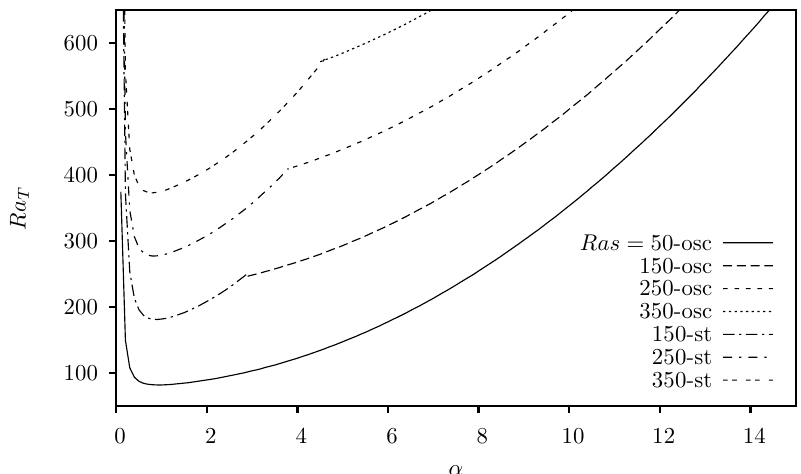
Figure 8. Effect of Ra s on the marginal stability curves for stationary and oscillatory convection with respect to the wave number α .